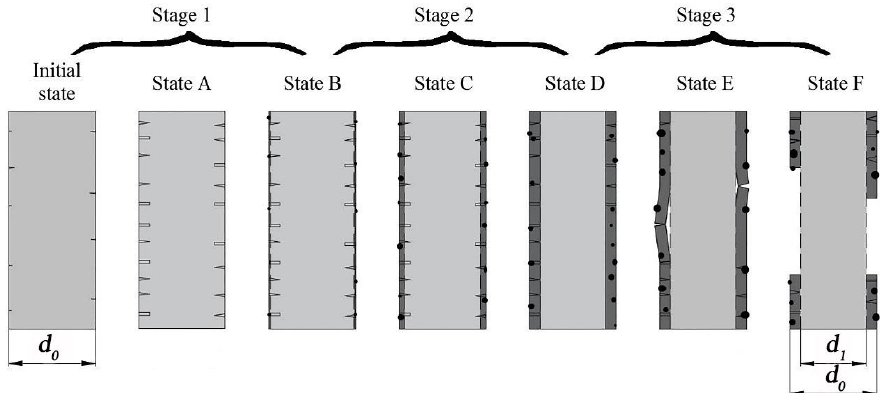
Figure 11. Schematic drawing of the corrosion process of basalt fibers in NaOH solution.